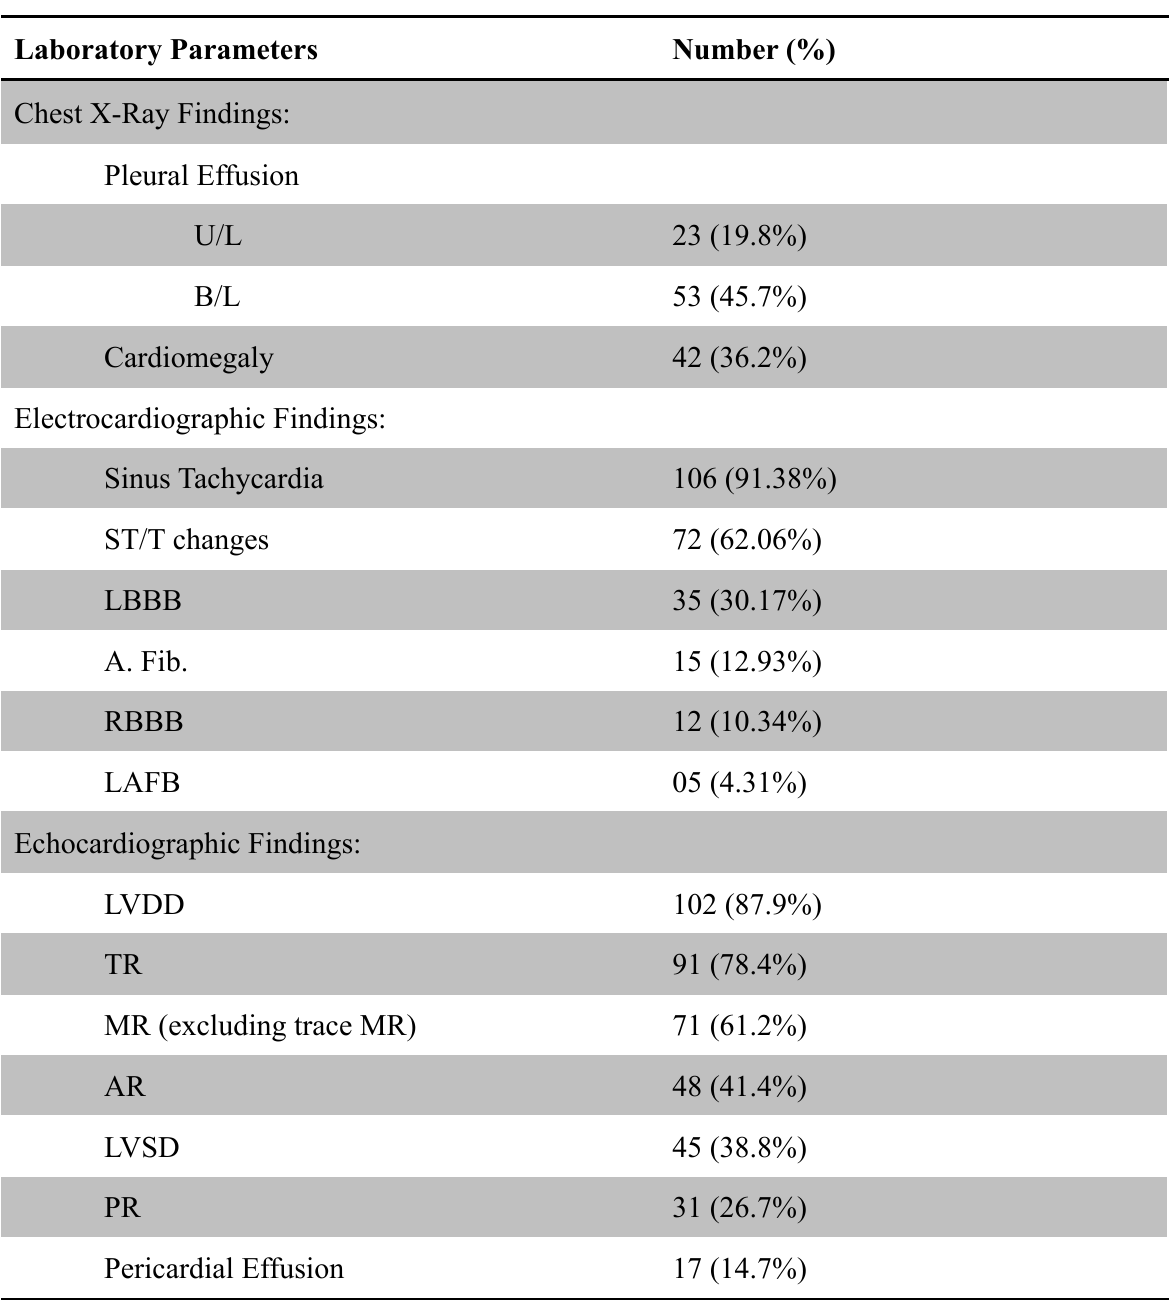
Table 3: Investigations findings in the study population (n=116)